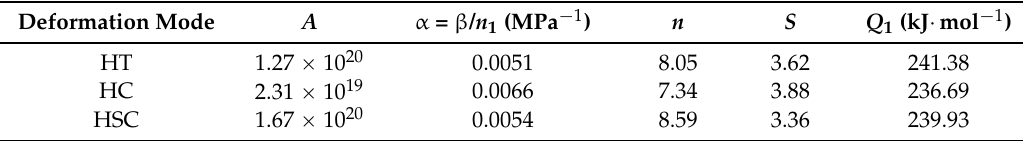
Table 2. Values of material constants and activation energy Q 1 for the 7050 aluminum alloy.